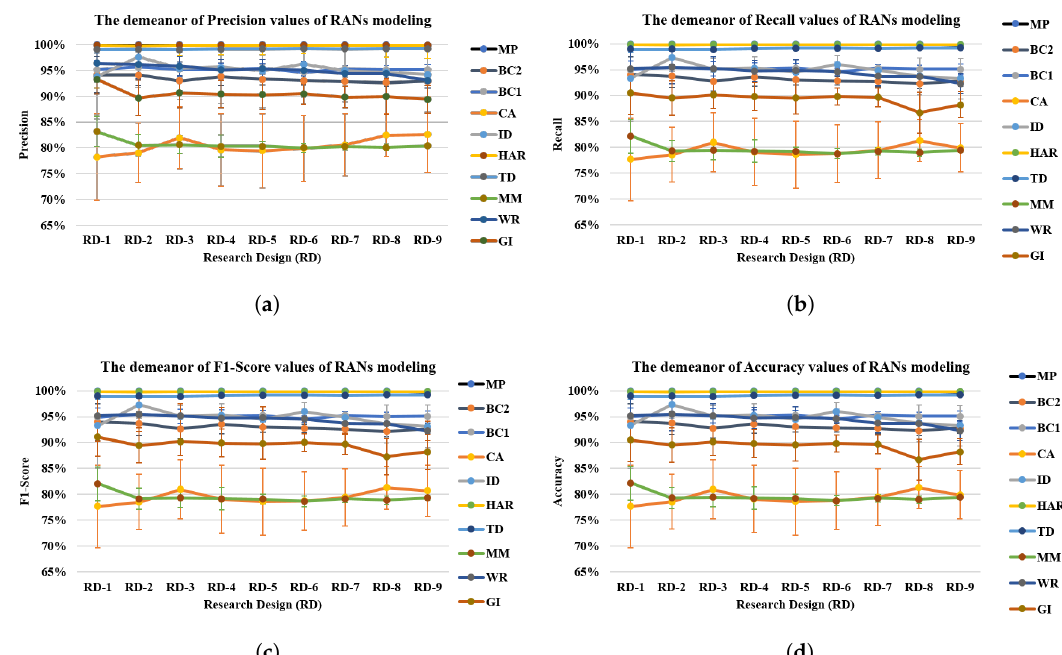
Figure 12. RANs evaluation metric (precision, recall, F1-Score and accuracy) value behavior with respect to varying test and train data ratio over ten datasets [Mice Protein (MP), Breast Cancer 669 (BC1), Breast Cancer 569 (BC2), Credit Approval (CA), IRIS data (ID), Mamographic Mass (MM), Human Activity Recognition (HAR), Toy-data(TD), Wine Recognition (WR) and Glass Identification (GI)] ( a ) Precision; ( b ) Recall; ( c ) F1-Score; ( d )